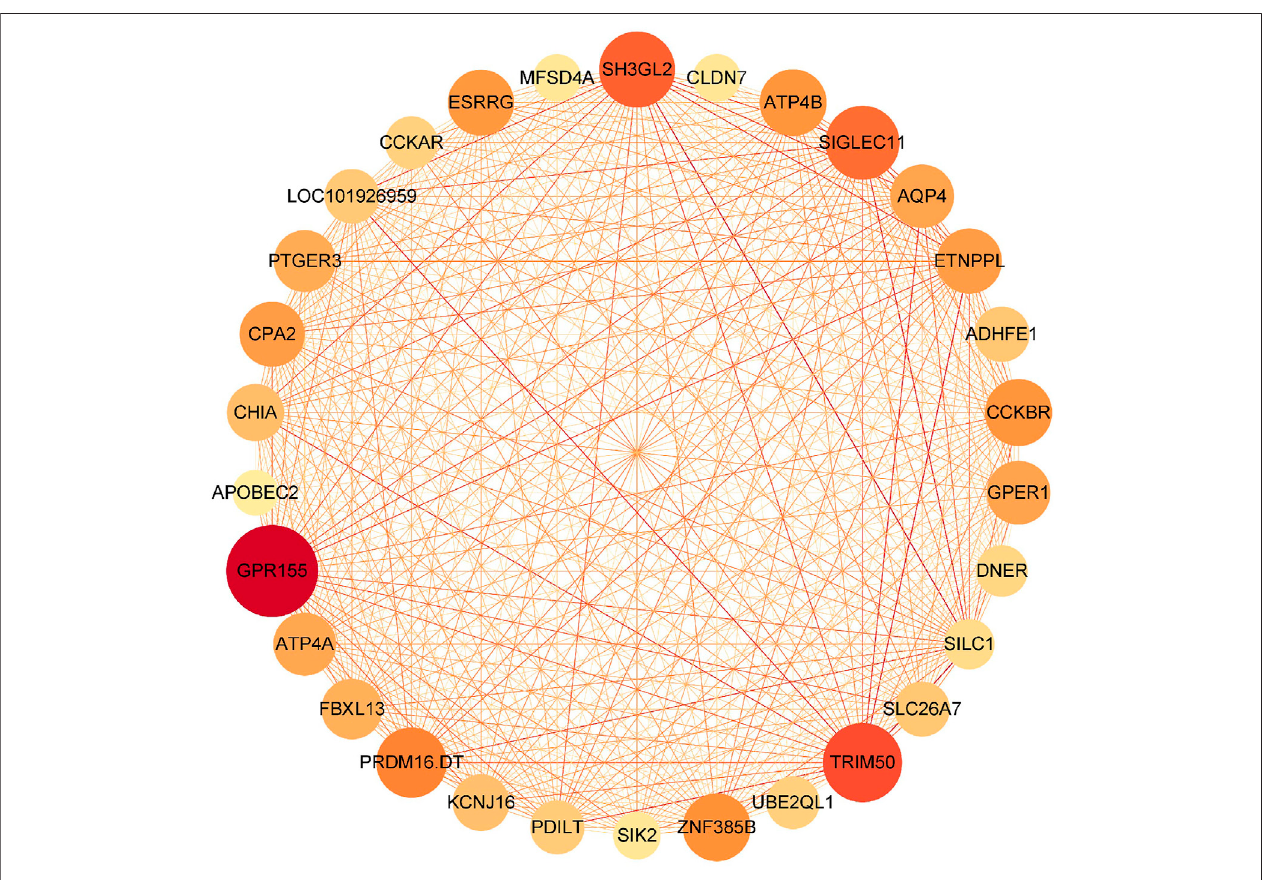
FIGURE 4 | Gene – gene interaction network of the top-ranked 10% genes in red